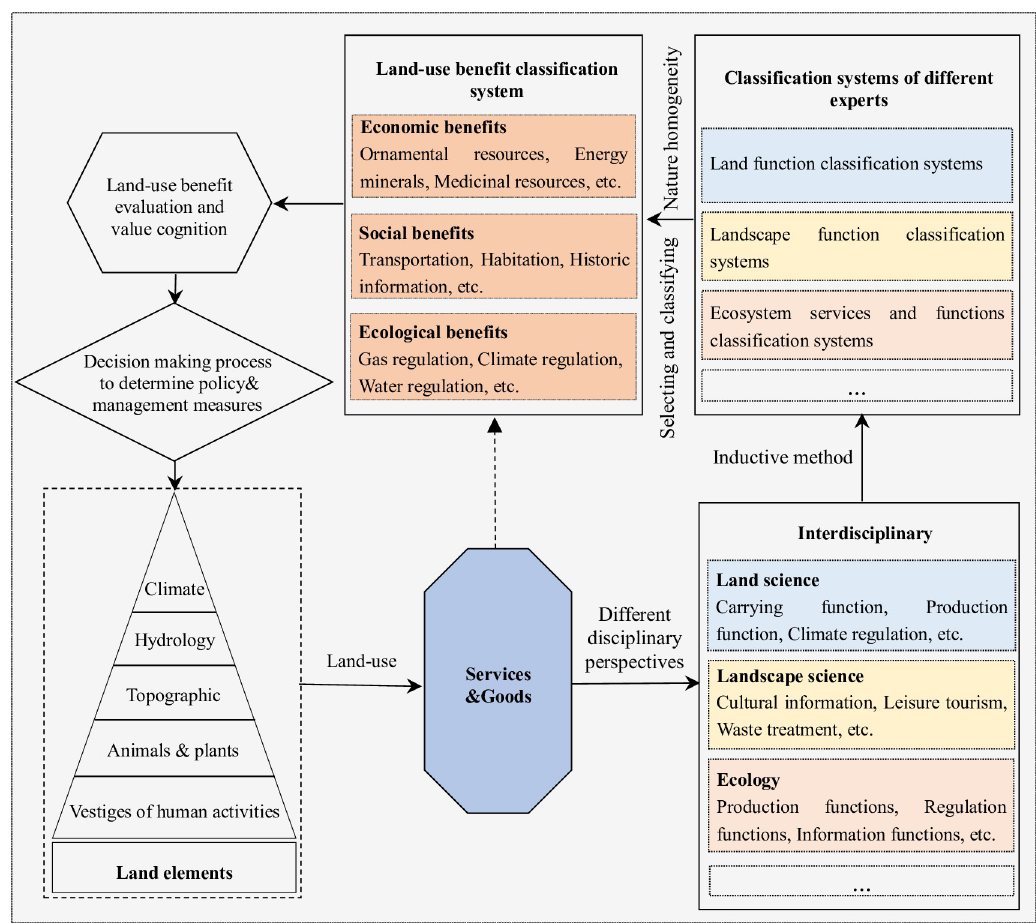
Fig 2. Construction framework of the land-use benefit classification